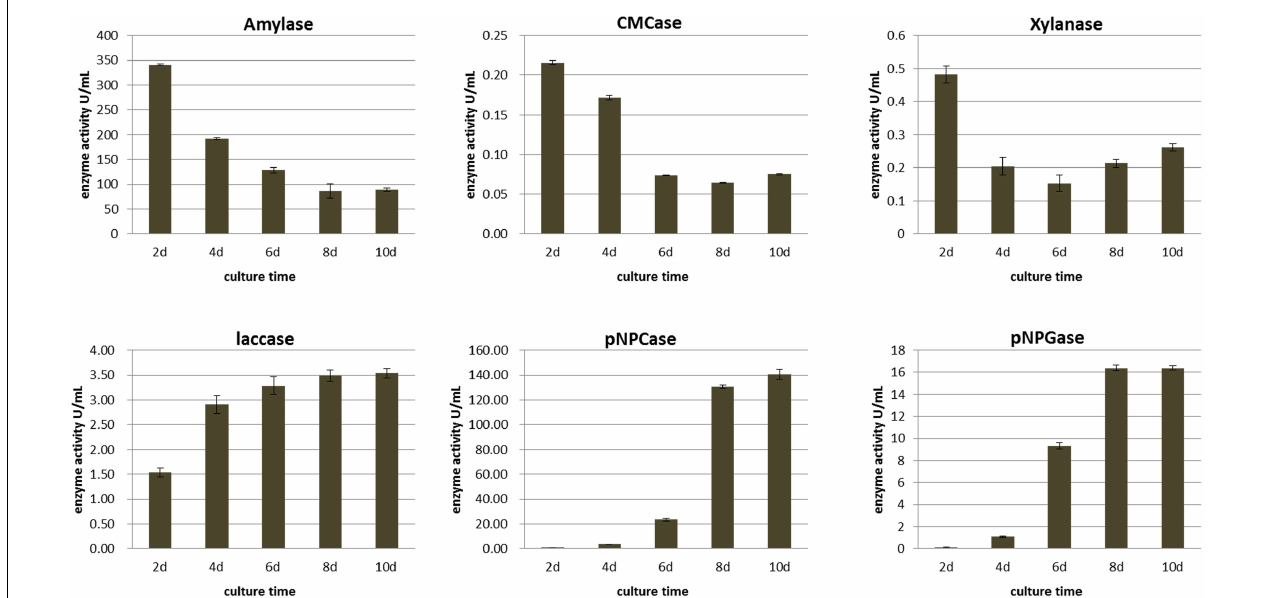
FIGURE 4 | Enzyme activities of Morchella importuna on MIX